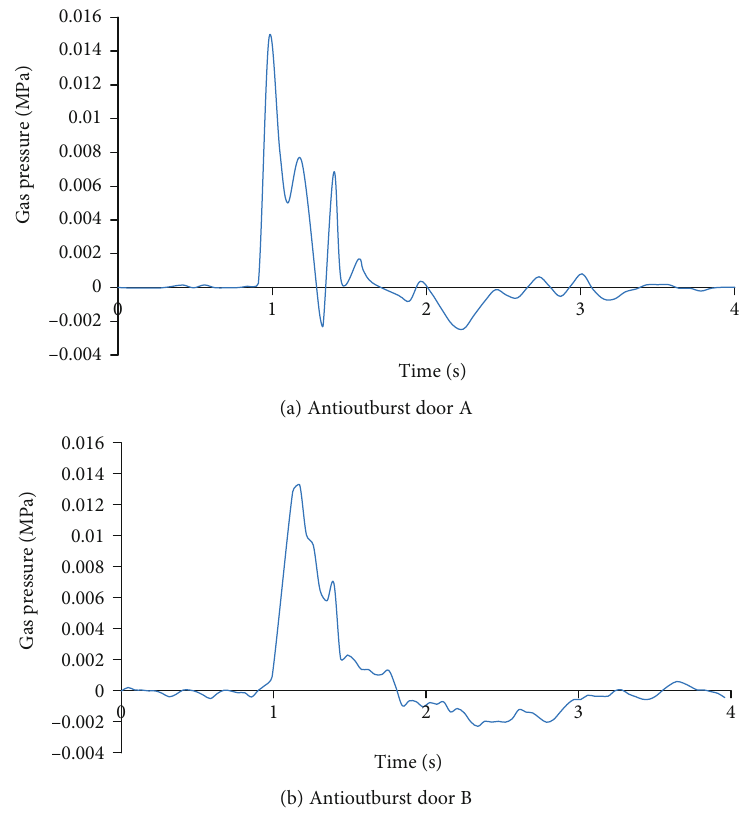
Figure 3: The gas pressure change law at antioutbursts A and